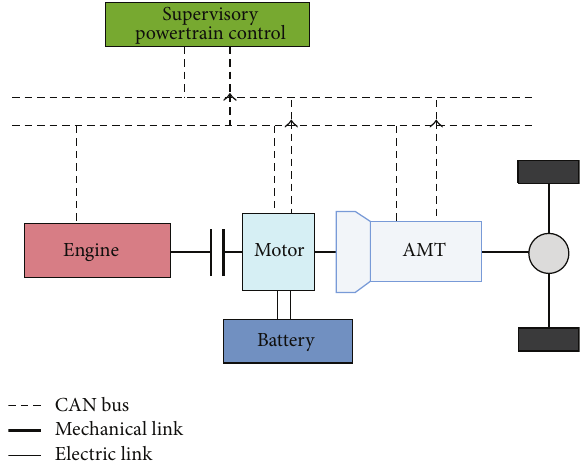
Figure 1: Architecture of the hybrid electric truck.